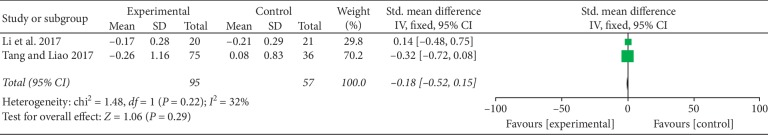
SE forest map after follow-up.